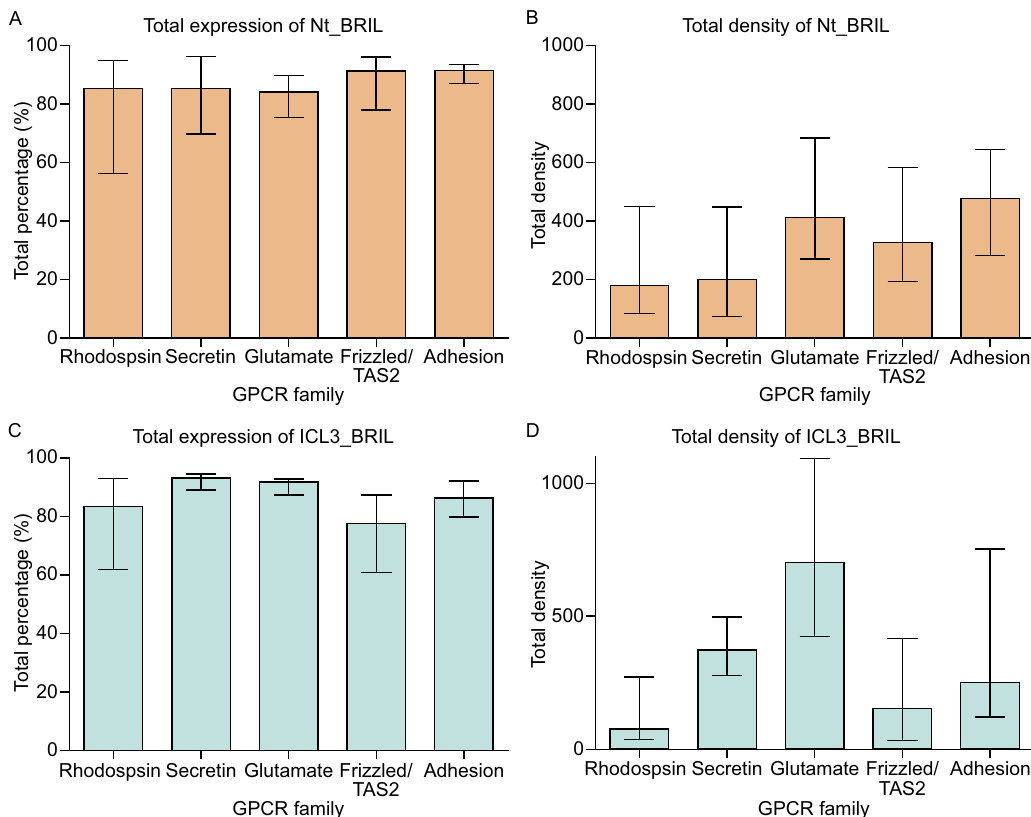
Figure 4. Total expression characteristics by GPCR family and construct. Distributions among GPCR families are shown for total percentage of cells expressing GPCRs (A and C) and total density of GPCRs (B and D) for Nt_BRIL (A and B) and ICL3_BRIL (C and D) constructs. Graphs are plotted as median values for the Rhodopsin, Secretin, Glutamate, Frizzled/Taste2, and Adhesion families with 719, 16, 22, 36, and 33 members, respectively. Error bars indicate fi rst quartile from the